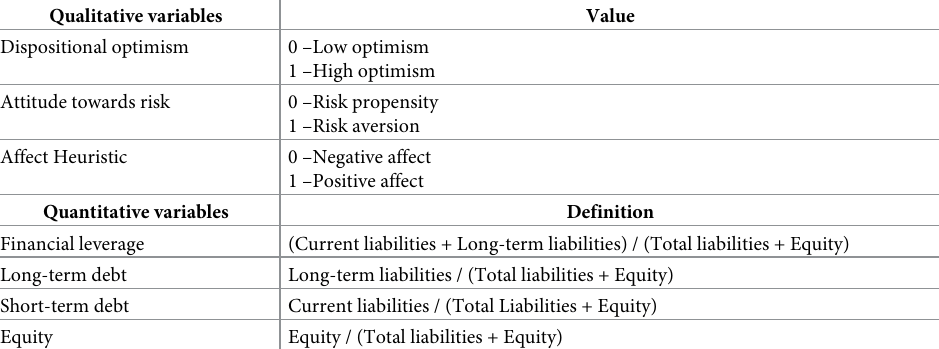
Table 1. Qualitative and quantitative variables, values and